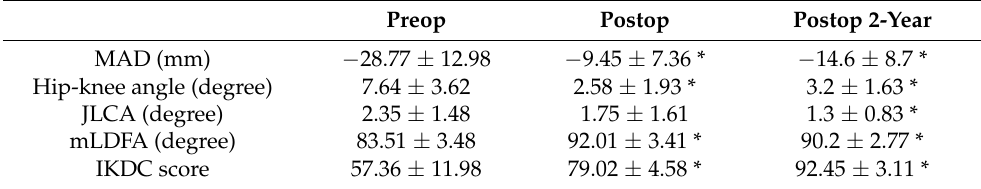
Table 2. Mechanical axis and functional result of preoperative and postoperative change.